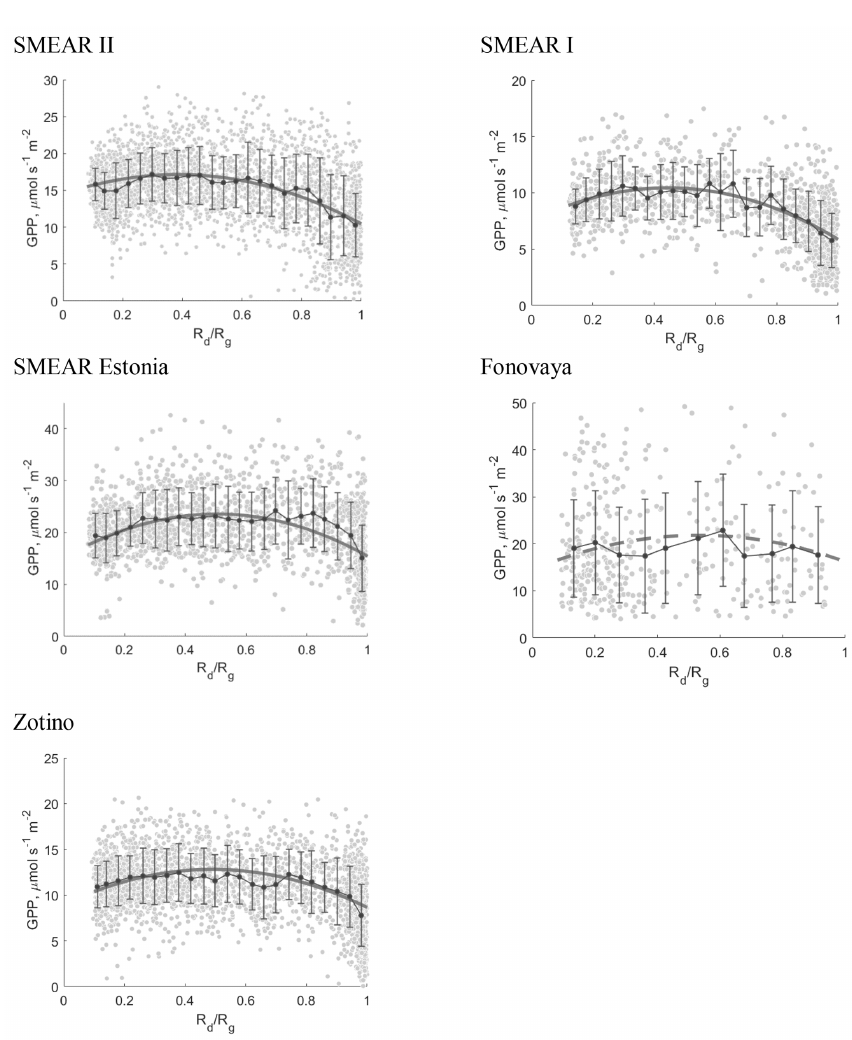
Figure 9. GPP dependences on R d /R g for all of the sites. The curves represent estimated GPP (the same parabolas as in Fig. 8). We use a dashed curve for Fonovaya due to the relatively low correlation coefficient obtained for the LUE ( R = 0 . 44, Fig. 6). The data sets for all of sites were cast in bins in R d /R g , the width of each bin is R d /R g = 0 . 04 ( R d /R g = 0 . 08 for Fonovaya). Black points correspond to the mean GPP in each bin and error bars show the standard deviation of the data for each